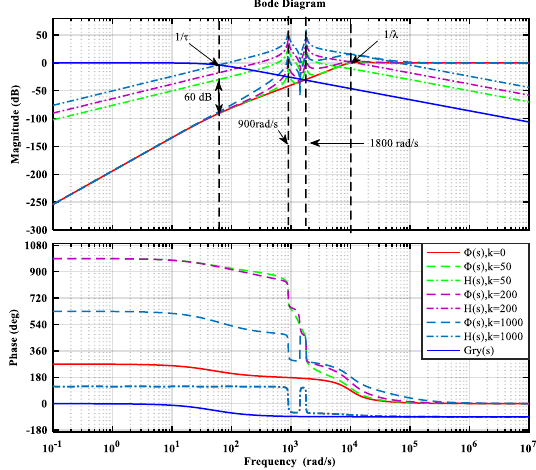
Figure 4. Bode diagram of Φ ( s ) and H ( s )